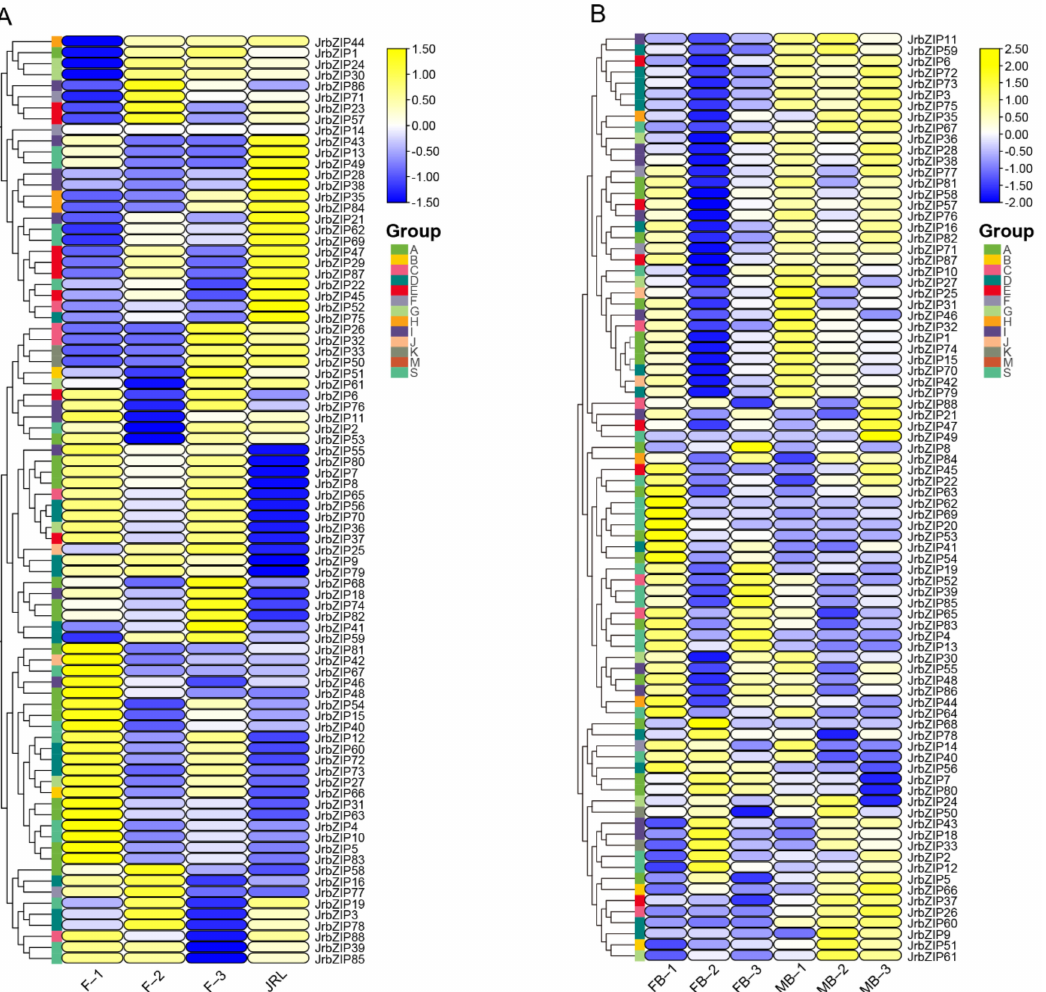
Figure 6. Expression profiles of candidate JrbZIP genes in tissues or different developmental stages. ( A ). Heat map of JrbZIP gene in three periods of female flower bud development (F–1, F–2 and F–3) and one period of leaf bud development (JRL; leaf buds of the same period as F–2). ( B ). Heatmap of JrbZIP genes expressed differently in three development periods of female and male flower buds (FB/MB–1, FB/MB–2, and